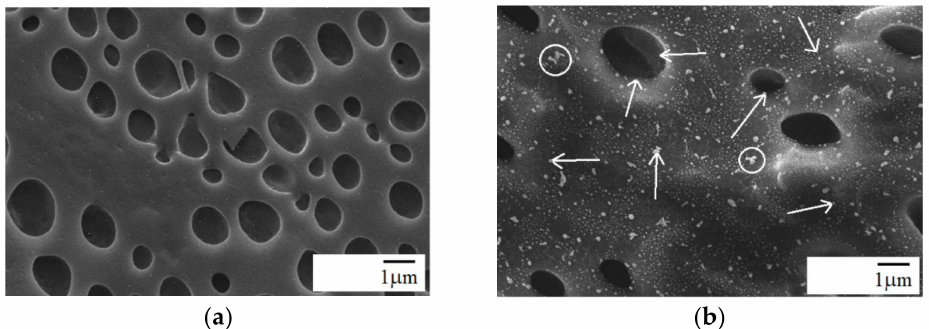
Figure 3. Scheme of the in situ compatibilization.